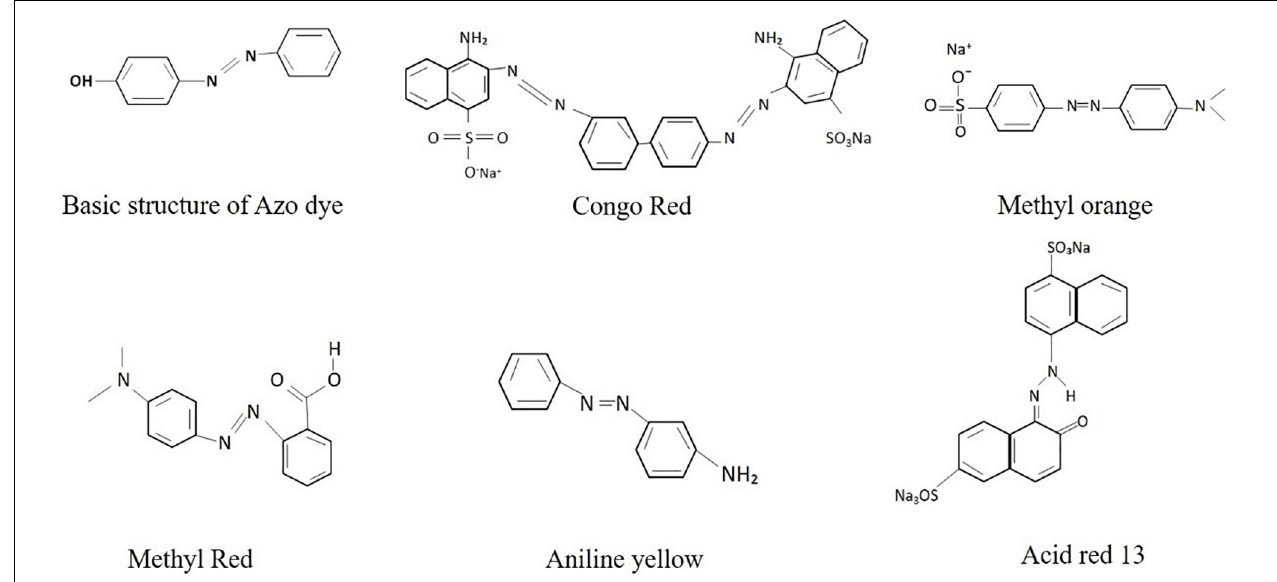
FIGURE 1 | Basic structure of different azo